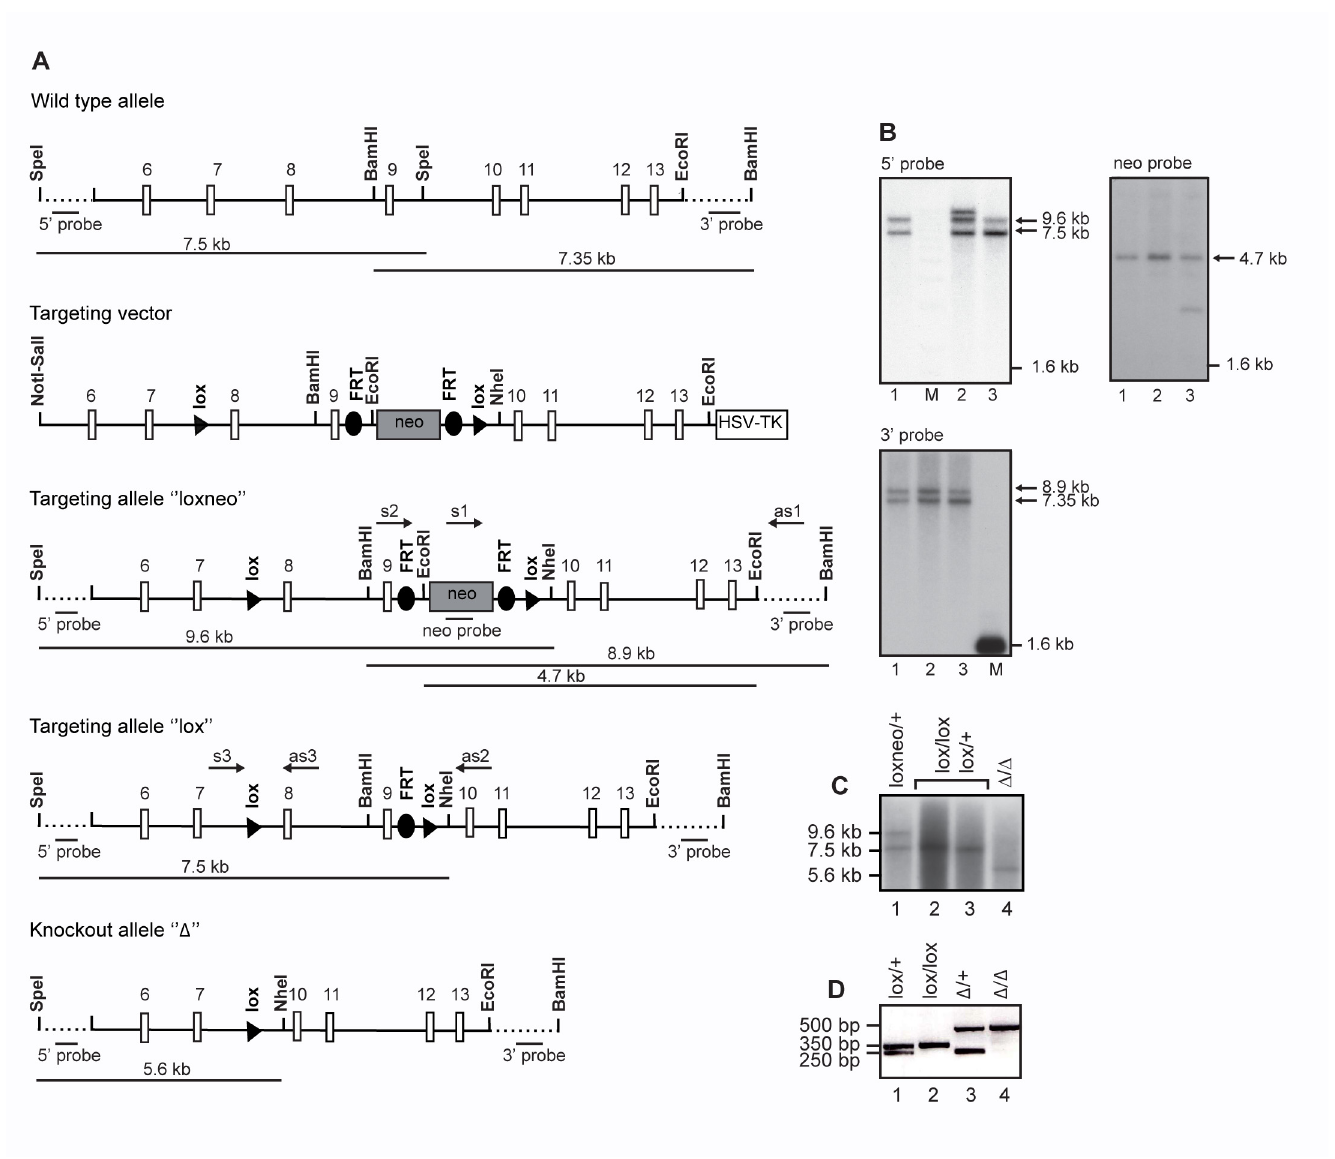
Fig 2. Inactivation of the CAP2/ Tmprss4 gene locus. (A) Scheme of the wild-type allele, the targeting vector, and the targeted CAP2/ Tmprss4 loxneo allele following homologous recombination, and the CAP2/ Tmprss4 lox and the CAP2/ Tmprss4 Δ allele following breeding with Flp- and Cre-deleter mice, respectively. Relevant restriction enzymes for cloning and diagnosis of targeted ES cell clones are shown. Exons 8 and 9 and the neomycin cassette (flanked by frt sites) are flanked by lox P sites. 5 ’ and 3 ’ probes as well as PCR primers used for ES cell screening and mouse genotyping are indicated. ( B ) Southern blot analyses of targeted ES cell clones using the external 5 ’ probe (upper left panel) following digestion with Spe I and Nhe I, the neo probe (upper right panel) following Eco RI digestion, and the external 3 ’ probe following digestion with Bam H1; note that clone #2 and #3 harbour additional recombination and integration events as evidenced by Southern blot analyses using the 5 ’ and neo probe, respectively. ( C ) Southern blot analysis of CAP2/ Tmprss4 loxneo/+ , CAP2/ Tmprss4 lox/lox and/or CAP2/ Tmprss4 lox/+ and CAP2/ Tmprss Δ / Δ mice using the 5 ’ probe following Spe I/ Nhe I digestion. ( D ) PCR-based genotyping of mice harbouring the wild type ( + , 250bp, lane 1 and 3), lox alleles ( lox , 350bp, lane 2) and knockout alleles ( Δ , 500bp, lane 3 and 4). doi:10.1371/journal.pone.0135224.g002 CAP2/Tmprss4 knockout mice do not show an obvious phenotype Following interbreeding of heterozygotes, CAP2/Tmprss4 wildtype ( CAP2/Tmprss4 +/+ ) hetero- zygous mutant ( CAP2/Tmprss4 Δ /+ ) and homozygous mutant ( CAP2/Tmprss4 Δ / Δ ) mice were born according to Mendelian ratio (272 pups: +/+, n = 92; Δ /+, n = 131; Δ / Δ , n = 49; P < 0.1).